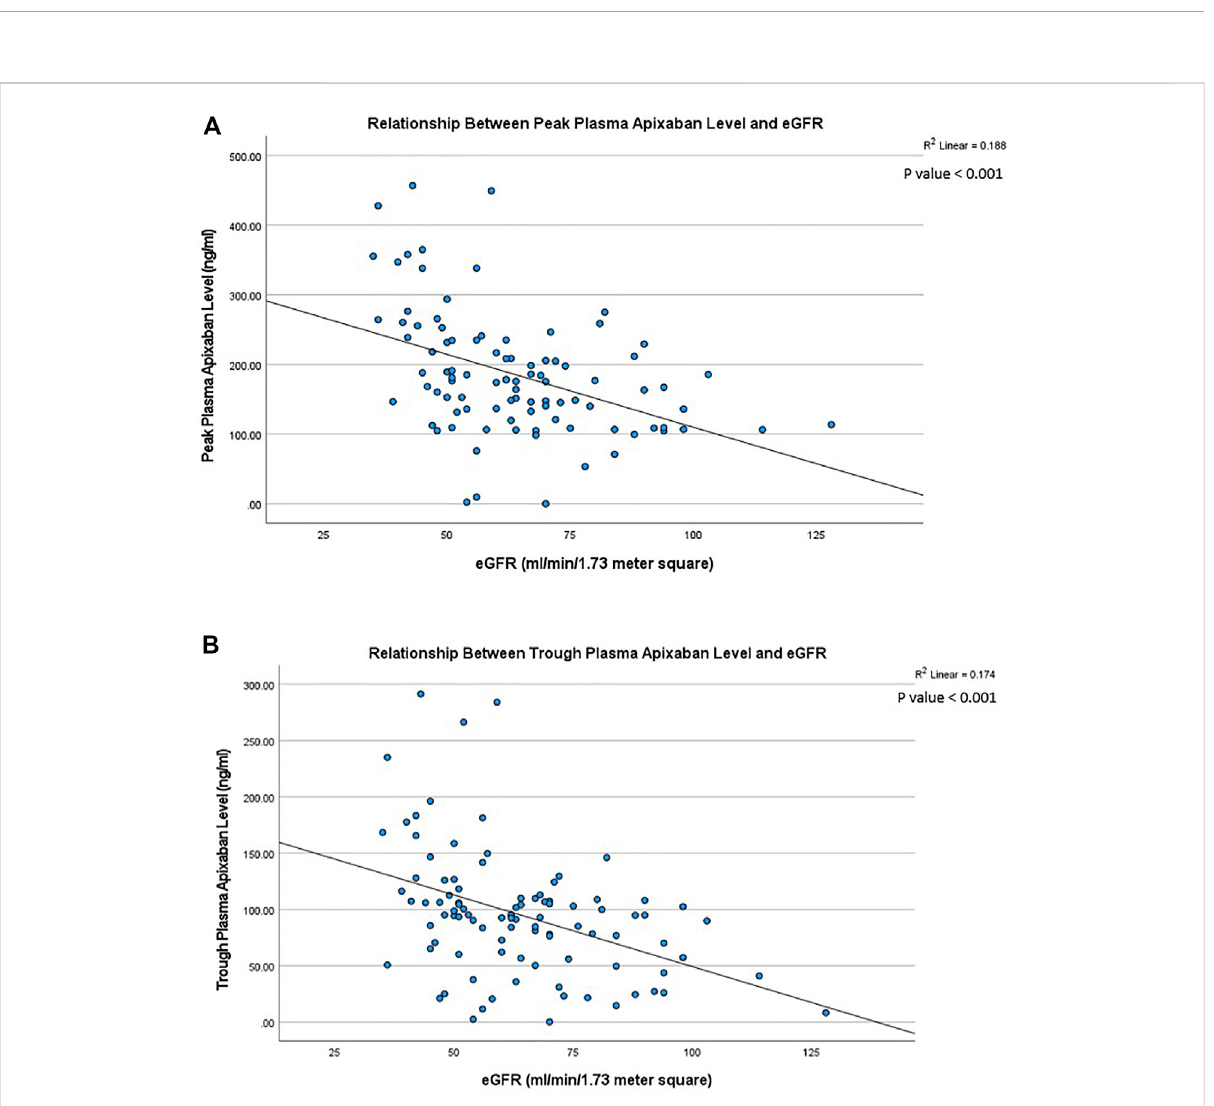
FIGURE 1 (A) Relationship between peak plasma apixaban level and creatinine clearance at 5 mg twice daily. The peak plasma apixaban level was negatively correlate with creatinine clearance ( r 2 : − 0.188, p < 0.001) ( r 2 : coef fi cient of determination). (B) Relationship between trough plasma apixaban level and creatinine clearance at 5 mg twice daily. Linear regression analysis showed that the trough plasma apixaban level was negatively correlate with creatinine clearance ( r 2 : − 0.174, p < 0.001) ( r 2 : coef fi cient of determination).